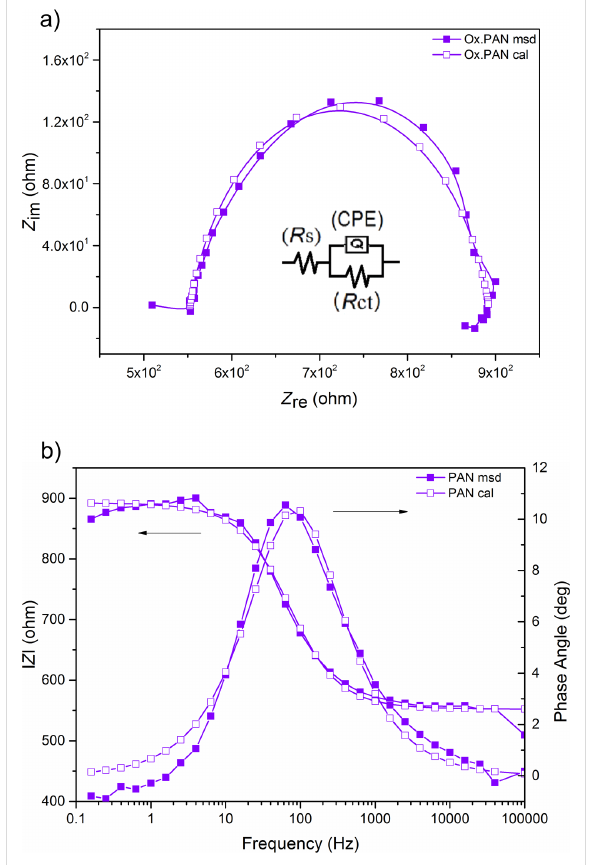
Figure 6: a) Nyquist plots of webs of oxidized PAN nanofibers. Inset: Randles circuit model. b) Bode magnitude and Bode phase plots of PAN nanofiber